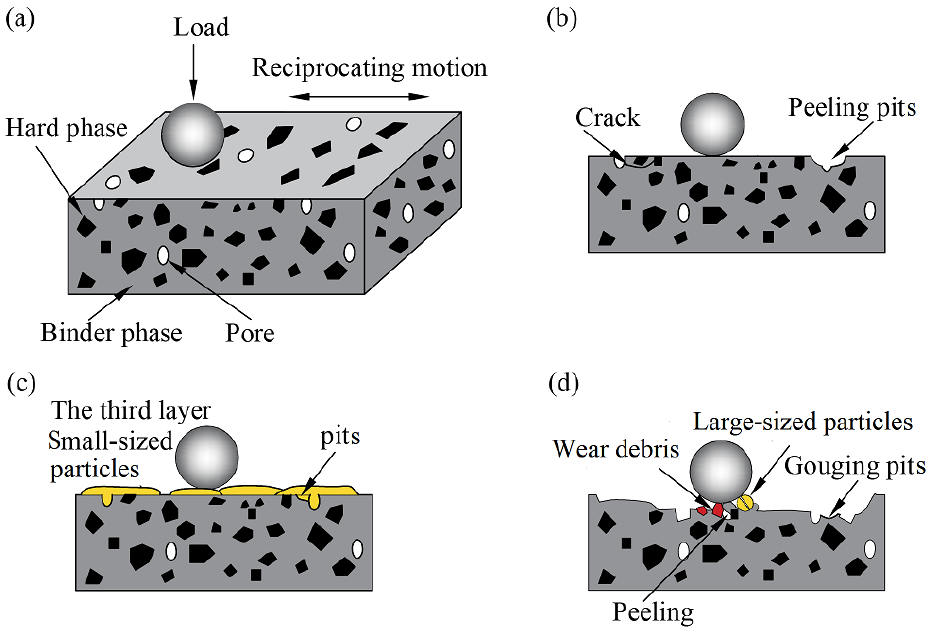
Figure 10. Schematic diagram of wear mechanism: ( a ) initial state; ( b ) no particles; ( c ) small – sized particles; ( d ) large – sized particles.